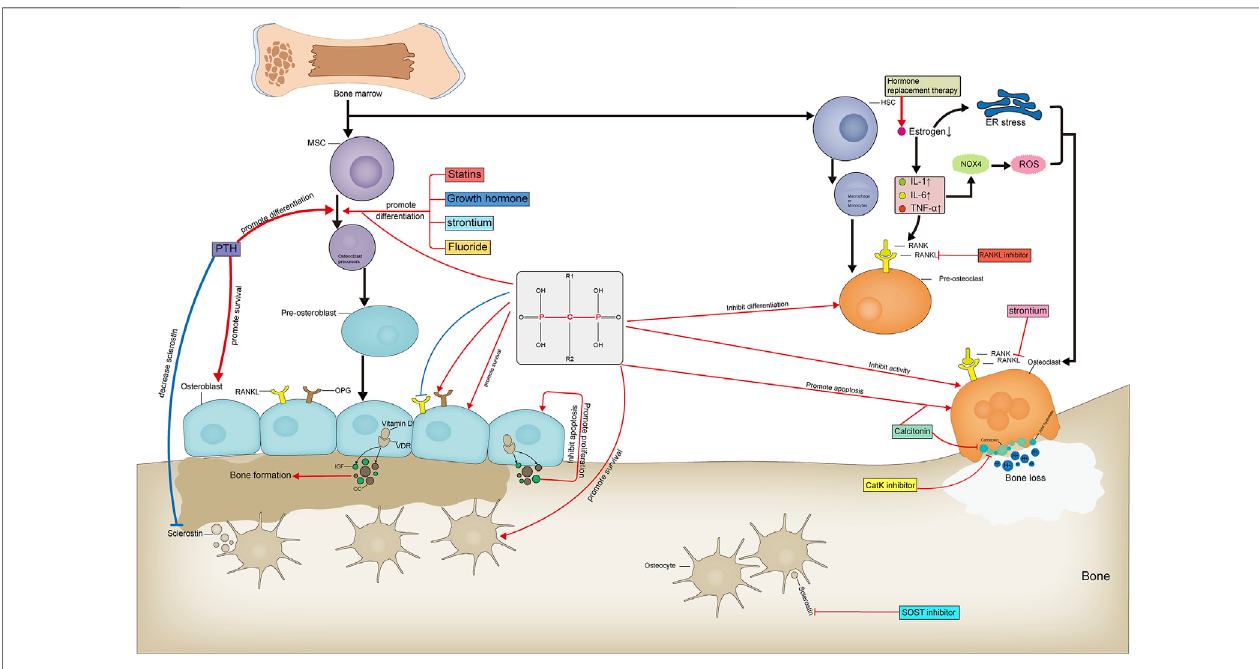
FIGURE 2 | Targets and mechanisms of anti-osteoporosis drug action with different mechanisms. Pharmacological mechanism of anti-osteoporosis drugs affecting bone formation and bone resorption.